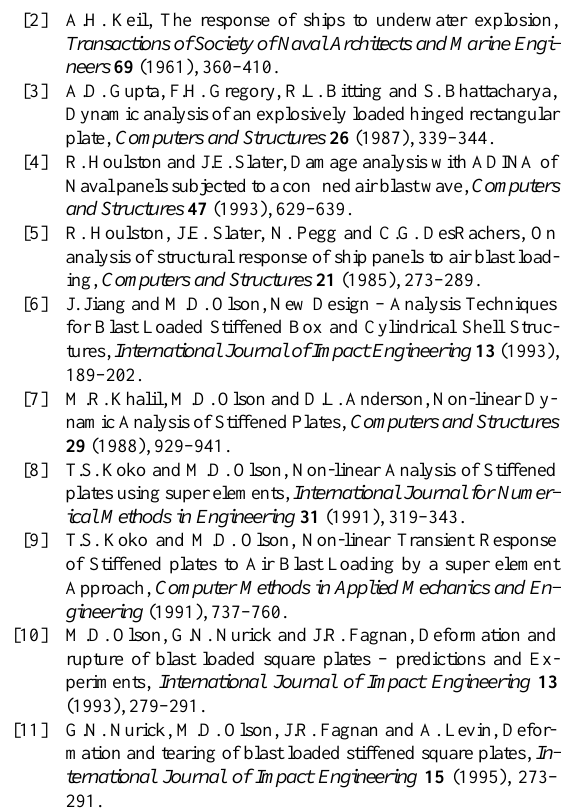
Fig. 17. Comparison of permanent deformation on a quadrant of the test panel (see Fig. 3) (Permanent deformation measured from initial panel surface towards base) ( h/l = 0 . 1 , Charge weight = 30